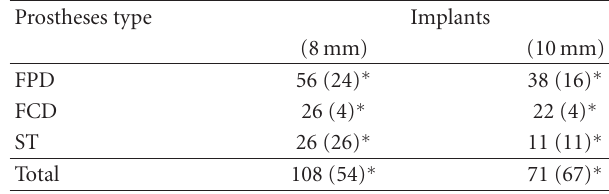
Table 3: Implant distribution by prosthesis